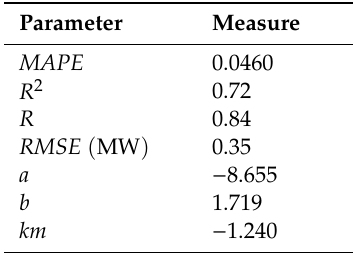
Table 2. Data validation analysis for the